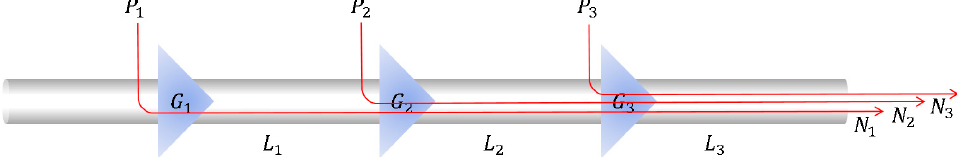
Figure 6. Example of crosstalk noise paths whose magnitude order varies depending on SOA gains.